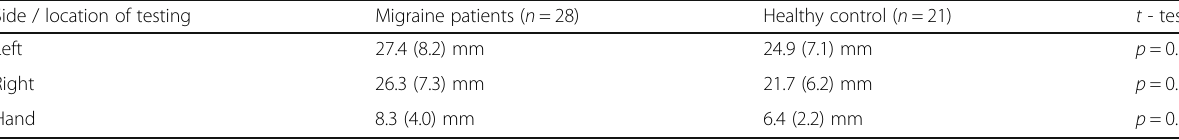
Table 3 Mean and standard deviations of two-point discrimination thresholds Side / location of